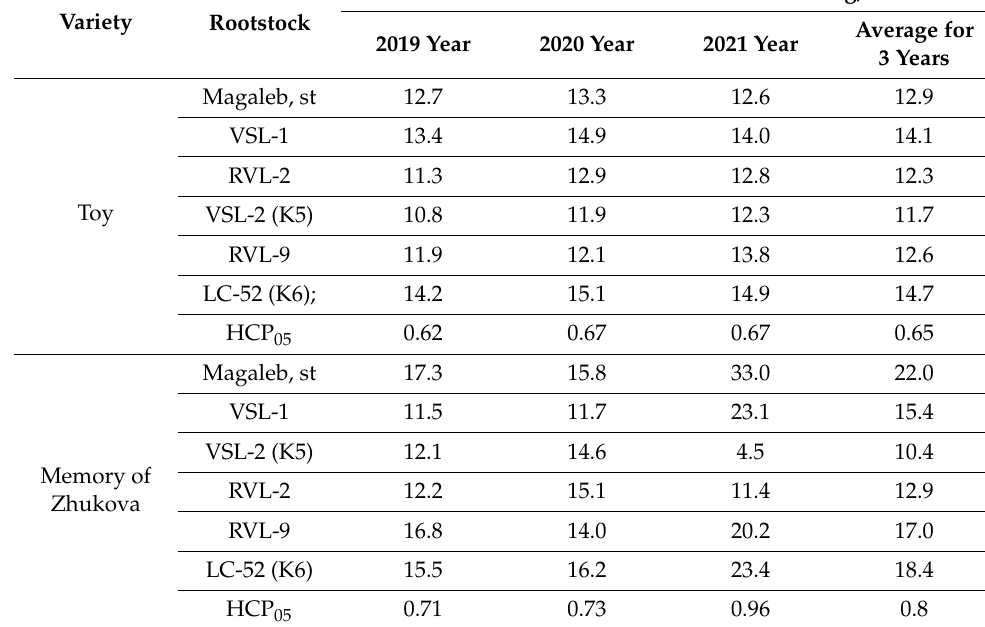
Table 3. The effect of various rootstocks on the water-holding capacity of leaves, (average for